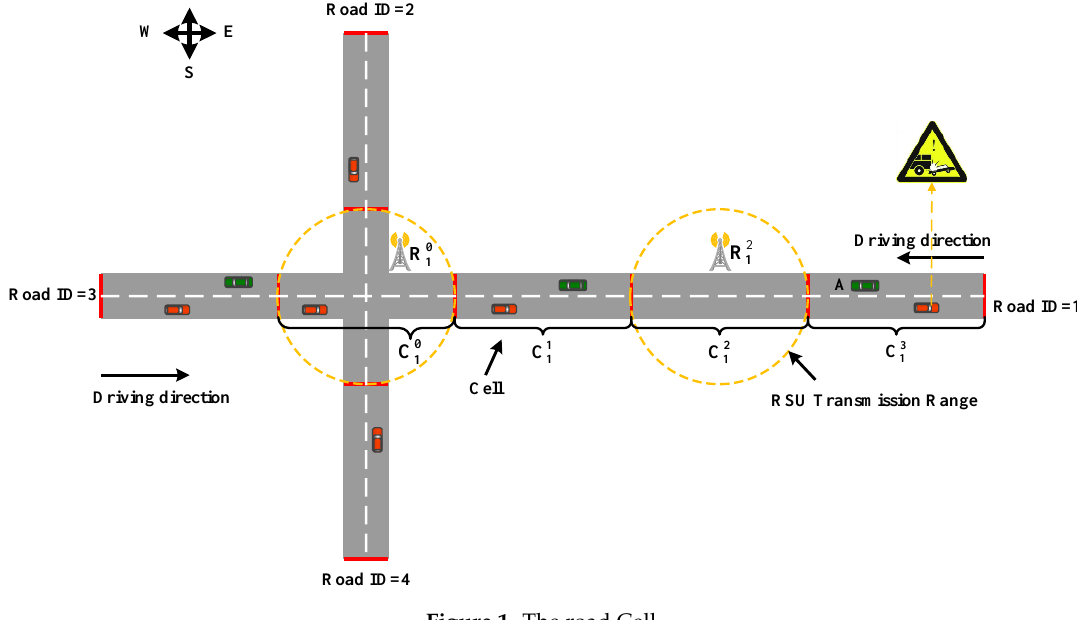
Figure 1. The road